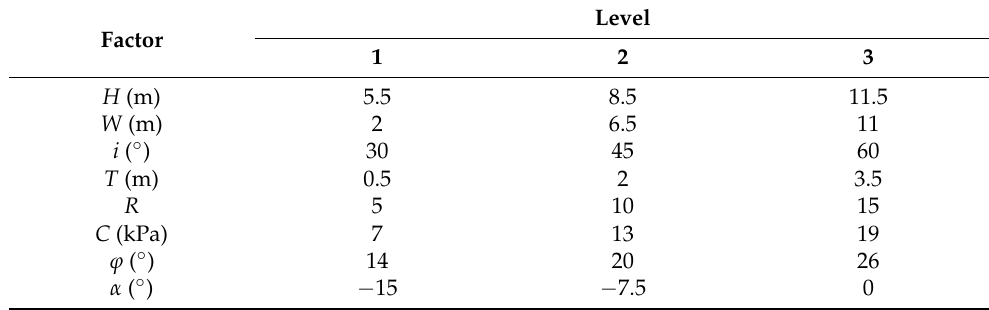
Table 9. Levels of the